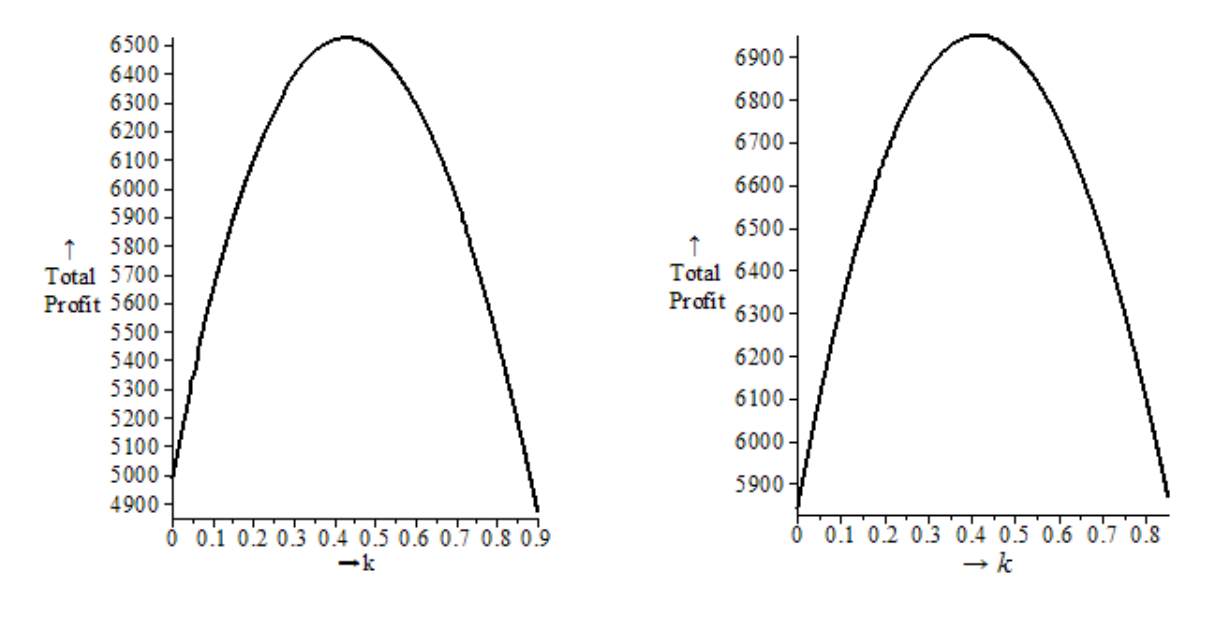
Fig. 3. When α =0.05 and θ =0.10 Fig. 4. When α =0.08 and θ =0.20